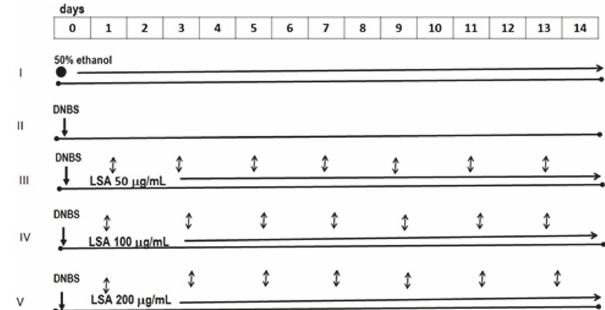
Figure 1: Experimental colitis was induced by administration of DNBS, followed by LSA injection. Firstly, colitis was induced in Balb/c mice by rectal instillation of DNBS followed by regular injection of LSA (L4 somatic antigen) for four times a week (1, 3, 5, 7, 9, 11, and 13). For the experiment, mice were randomly divided into 5 groups: I received 50% ethanol only (control); II was given DNBS only; III–V groups were injected with different concentrations of LSA (50 𝜇 g/mL , 100 𝜇 g/mL, and 200 𝜇 g/mL), respectively, until 14 days. The injection of LSA was started from day 1 until day 13. At the end of 14 days, mice in all groups were sacrificed. e : 50% ethanol; ↓ : DNBS; ↕ :